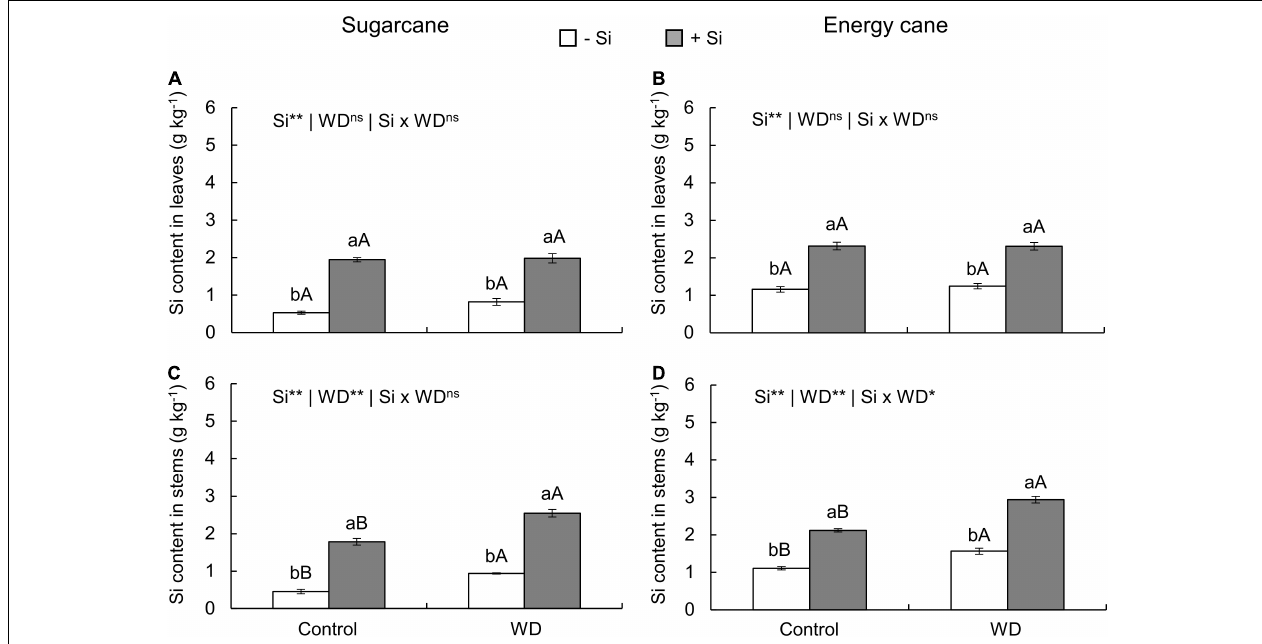
FIGURE 1 | Silicon (Si) contents in the leaves and stems of sugarcane (A,C) and energy cane (B,D) plants in the absence of Si application (-Si), and with Si applied via fertigation associated with foliar spraying (+Si) under adequate water regime (control) and in water deficit (WD) for a period of 7 to 60 days after transplanting. ** and * significant with 1 and 5% probability, respectively, and ns, not significant by the F -test. Lowercase letters indicate differences in relation to Si and capital letters in relation to water deficit. n = 6. Si × WD: interaction.